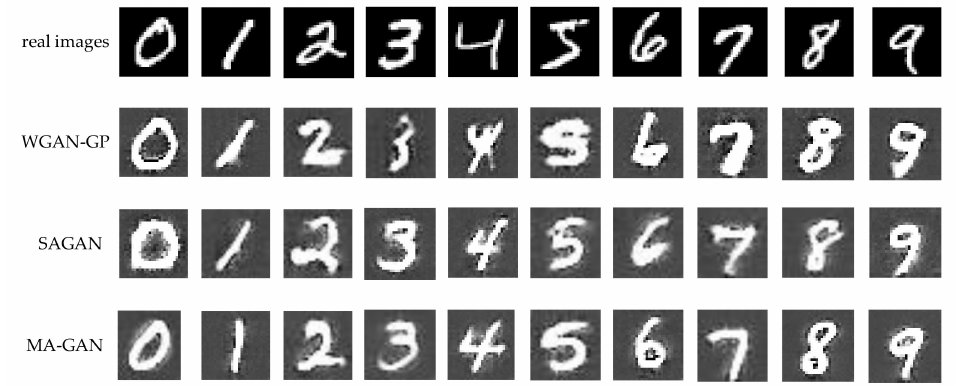
Figure 9. Comparison of the MNIST generated by different models.